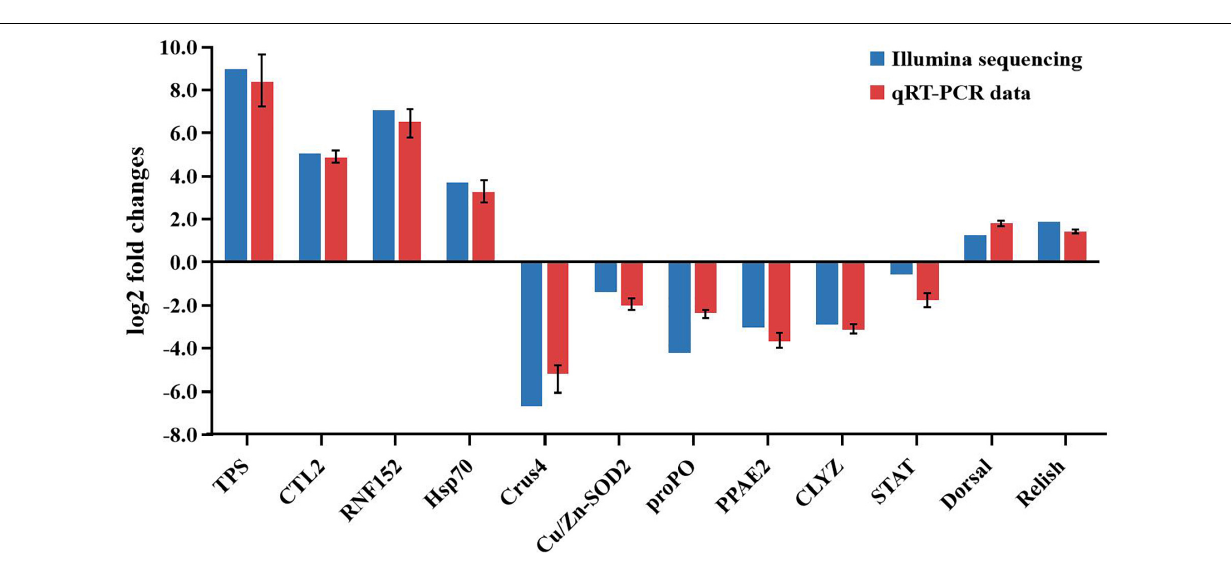
FIGURE 10 | Comparison of the expression profiles of 12 selected genes as determined by Illumina sequencing and